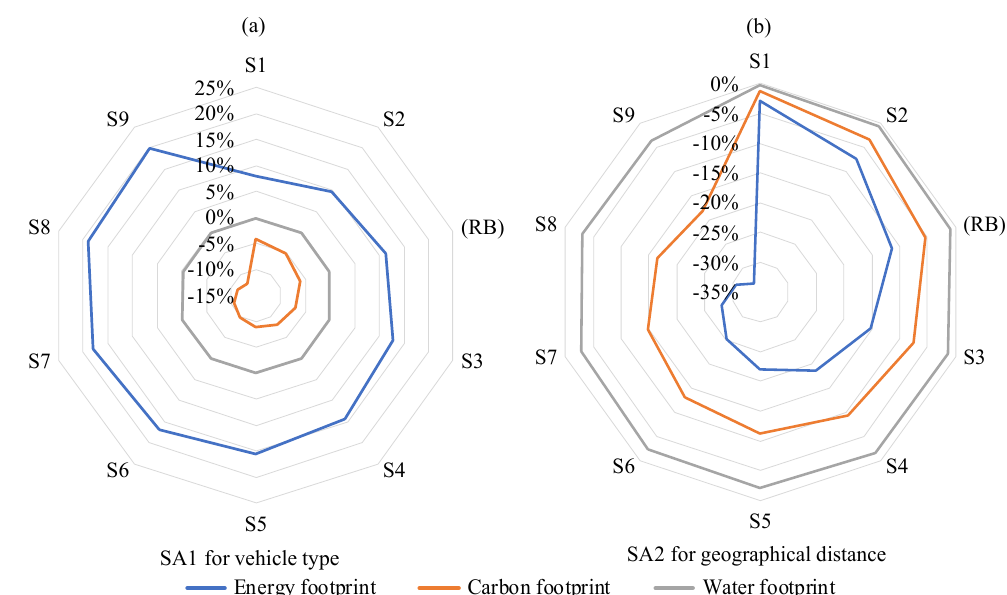
Figure 6. The changing ratios of total environmental impacts in each scenario of ( a ) SA1 for a vehicle type and ( b ) SA2 for geographical distance.